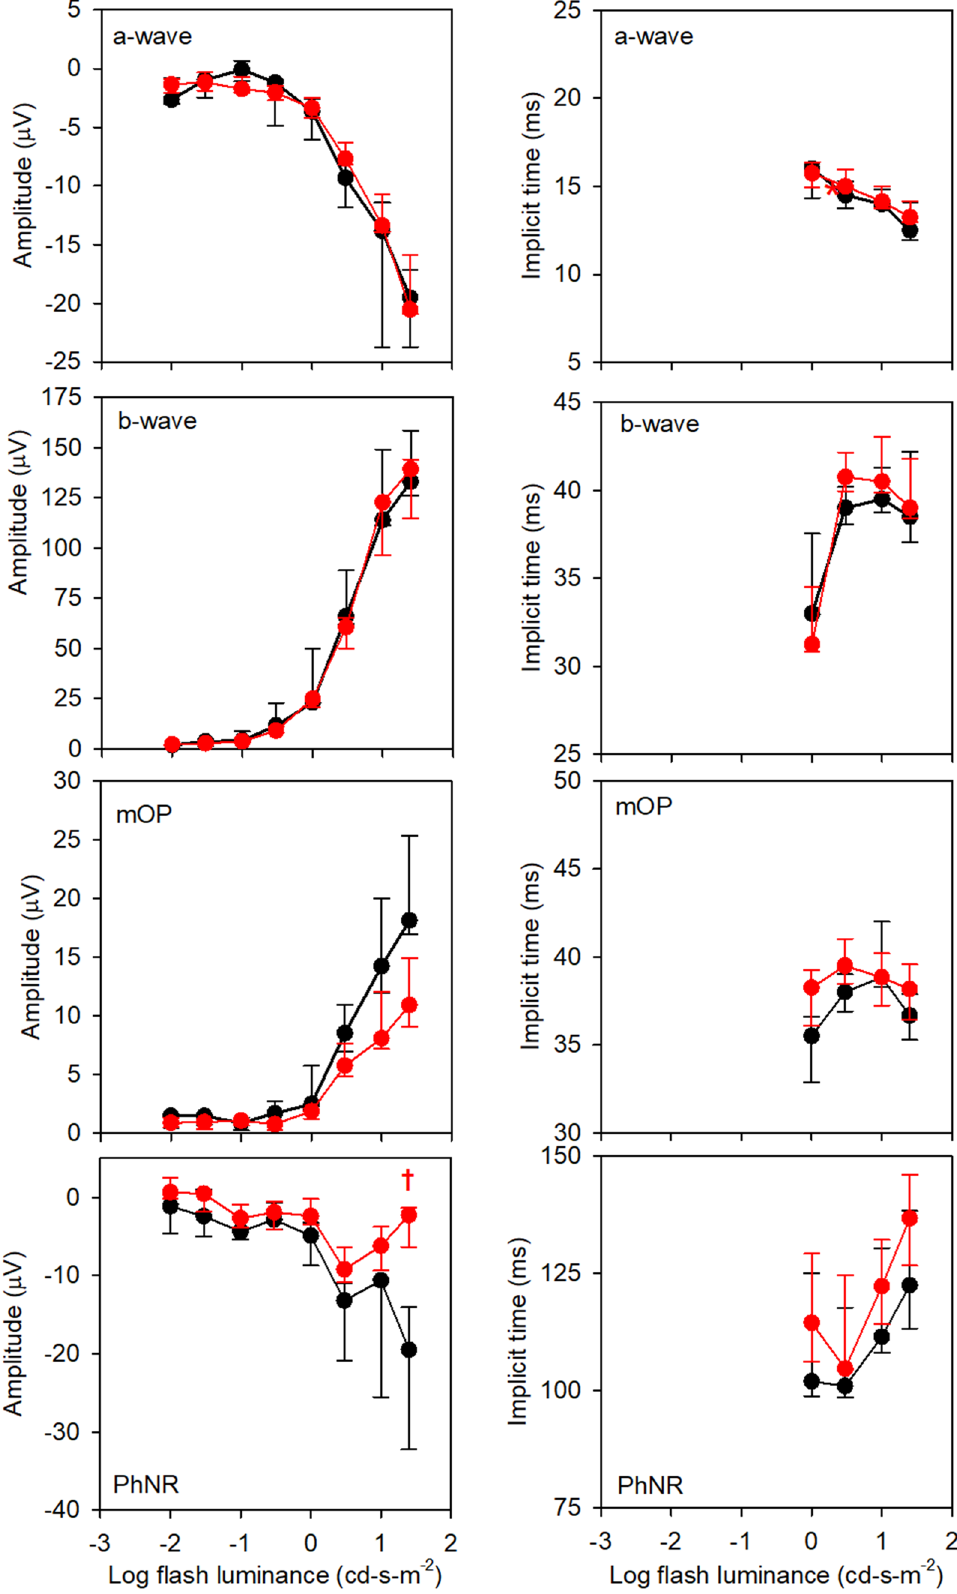
Figure 5. Median response amplitude (left column) and implicit time (right column) obtained under light- adapted conditions. All other conventions are as in Fig.